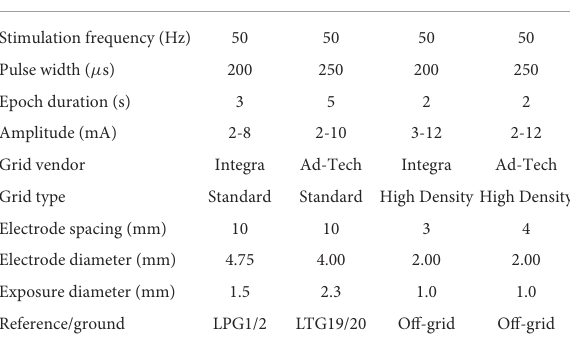
TABLE 1 Stimulation parameters and representative grid information.